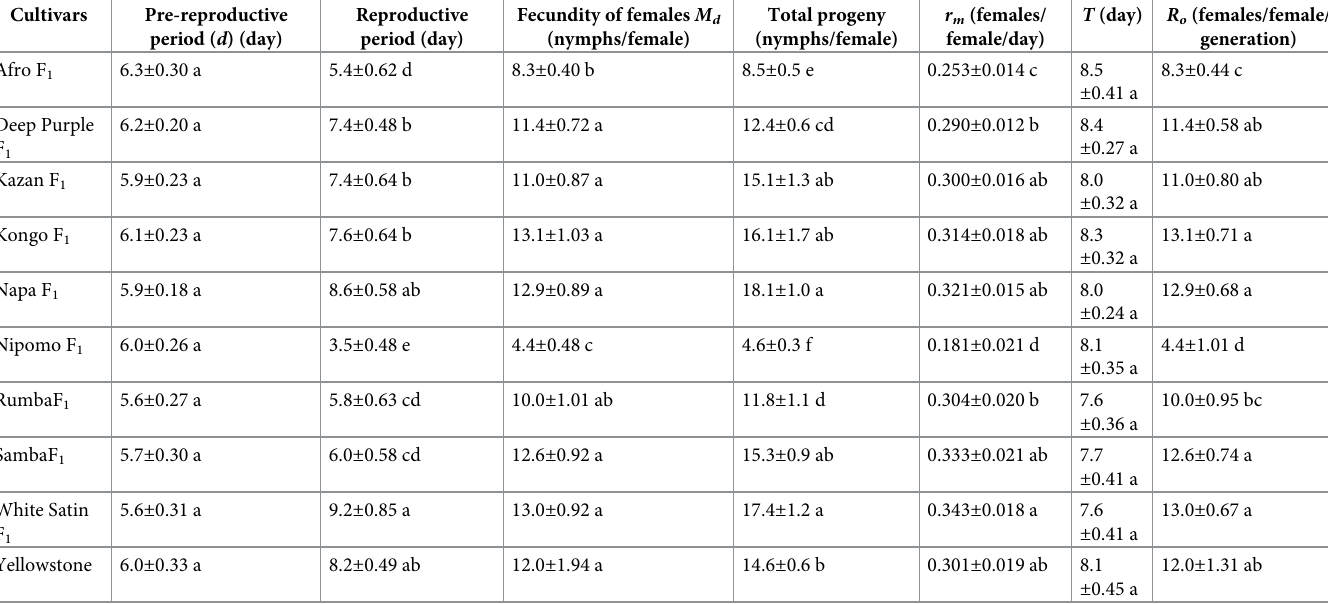
Table 5. Bionomic and demographic data for Dysaphis crataegi (mean ± SE) on ten carrot cultivars.